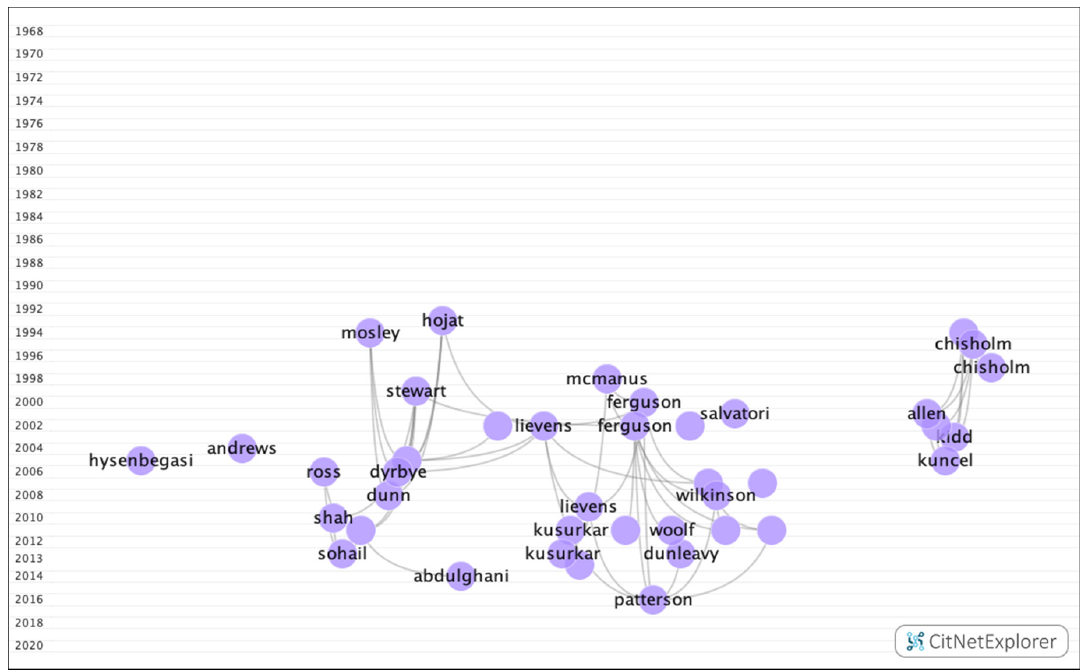
Figure 9. Group 3 citation network.